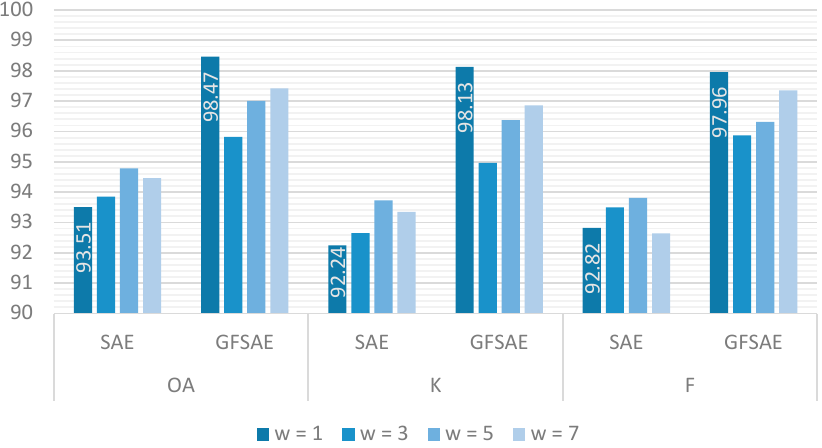
Figure 4. Accuracy metrics (OA, K, and F-score) for SAE and GFSAE obtained on the CEF dataset.